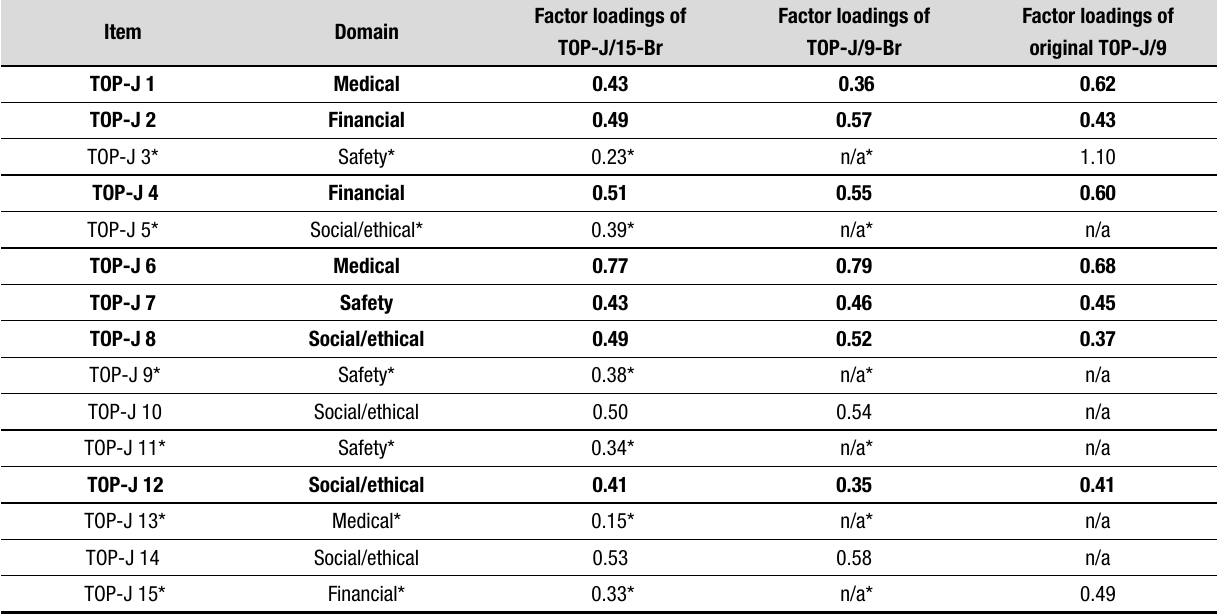
Table 3. Exploratory factor analysis to a single